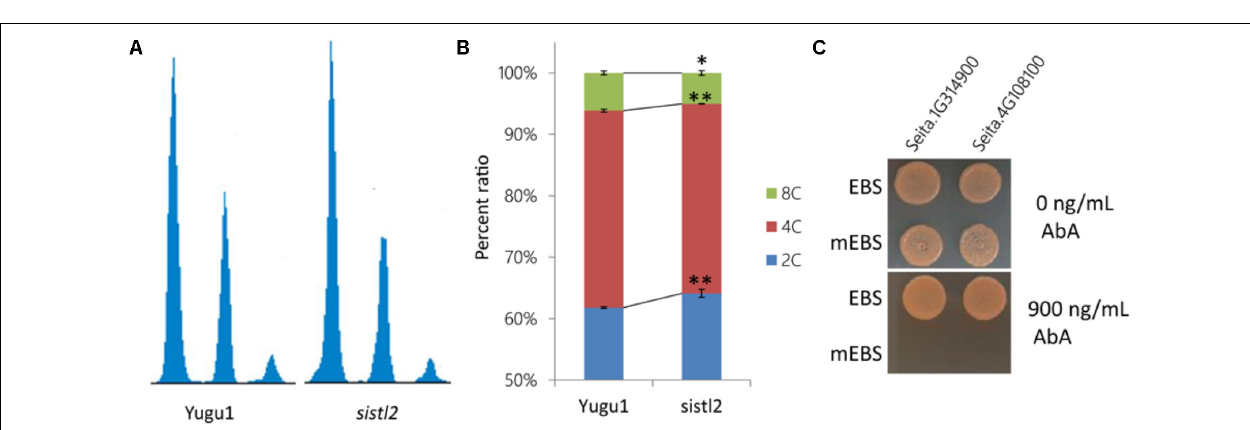
FIGURE 7 | (A) Ploidy distribution in the proliferating leaves of Yugu1 and sistl2 . (B) Percentage ratios of 2C, 4C, and 8C cells in Yugu1 and sistl2 . The means and standard deviations were obtained from three independent samples. ∗ P = 0.05; ∗∗ P = 0.01. (C) The interactions between the SiSTL2 promoter and two E2F family members. EBS means the E2F binding site in SiSTL2 promoter. mEBS is a random sequence used as a negative control. AbA, Aureobasidin A . 900 ng/ml is the lowest concentration of AbA that can avoid self-activating effects; 0 ng/ml AbA is the negative